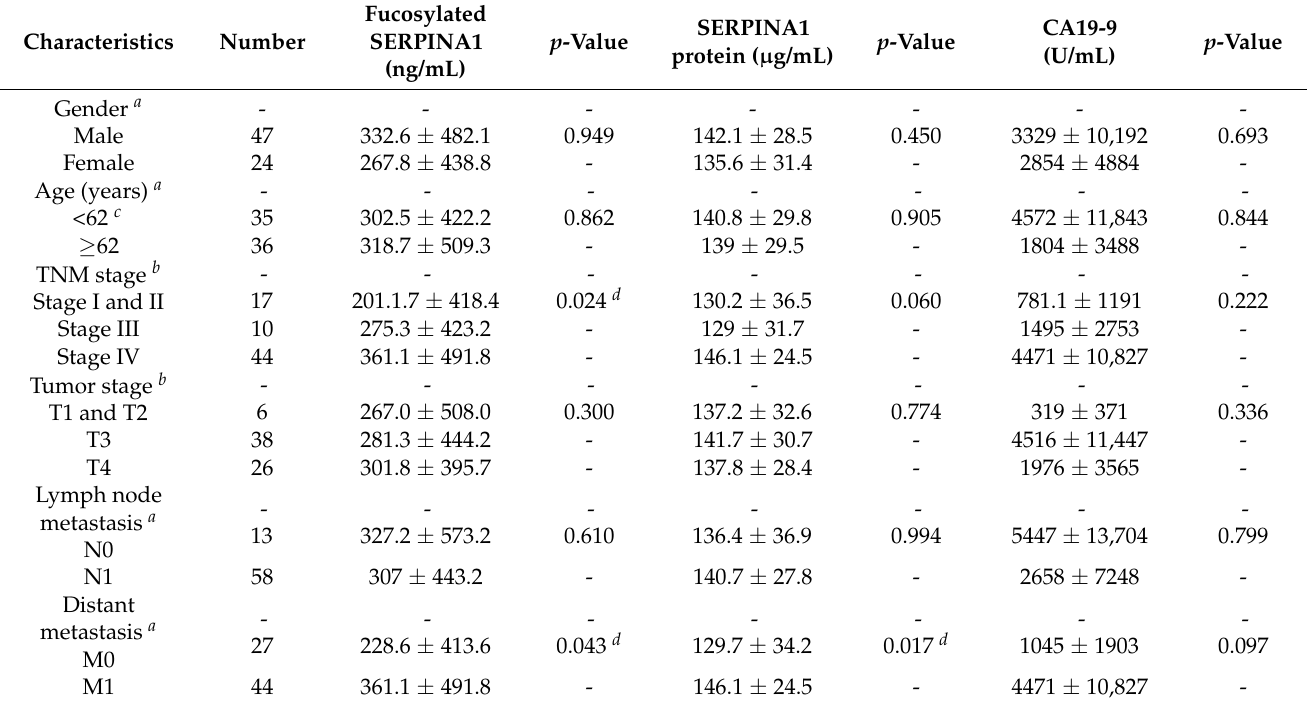
Table 4. Correlations of plasma fucosylated SERPINA1, SERPINA1, and CA19-9 levels with clinicopathological characteris- tics of PC patients.